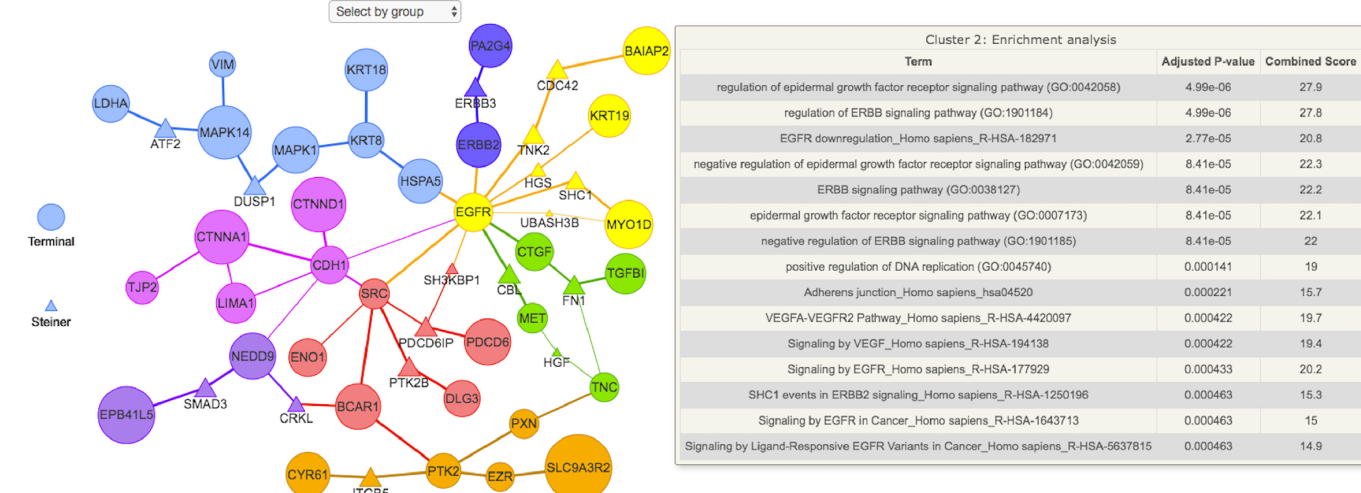
Fig 1. Functional enrichment analysis of the final subnetwork using the EnrichR API. The node sizes and edge widths are proportional to the amount of times that node or edge appearedin the noisy runs. Nodes are colored accordingto cluster membership. As in the EnrichRAPI, the p-value is calculated using the Fisher test and adjusted for multiplehypotheses.The top 15 functionalenrichment terms for each cluster are ranked accordingto the adjusted p- value and displayedin a tabular format when the mouse hovers over a node in that cluster. Each cluster can be visualizedseparately by “Select by group” icon locatedat the top of the